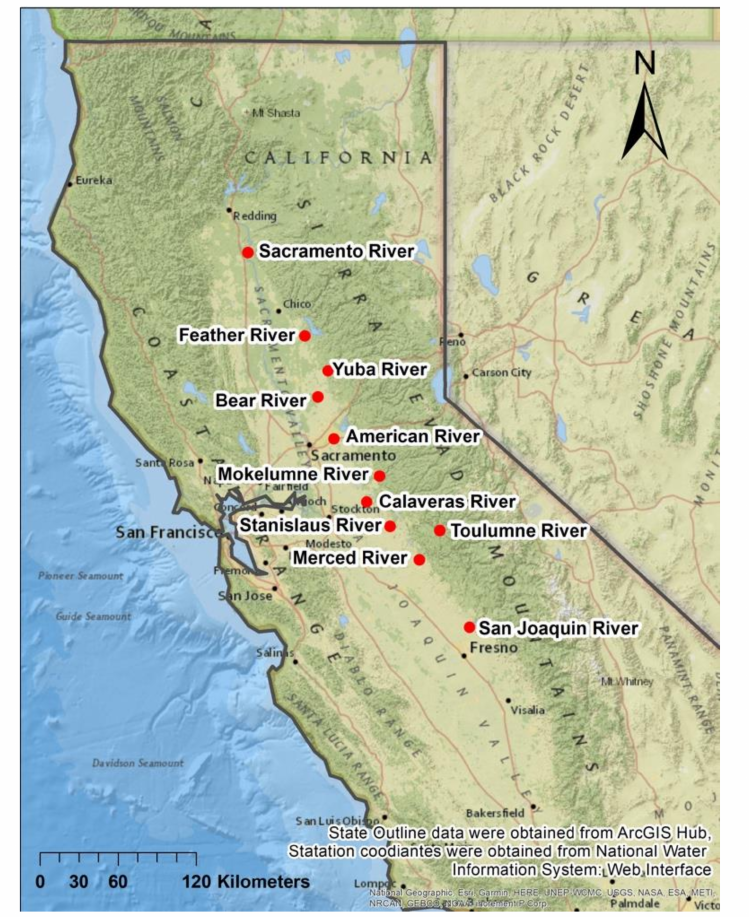
Figure 1. Map of California streamflow station locations used in this study. Map generated from ArcGIS Hub and station coordinate obtained from National Water Information System